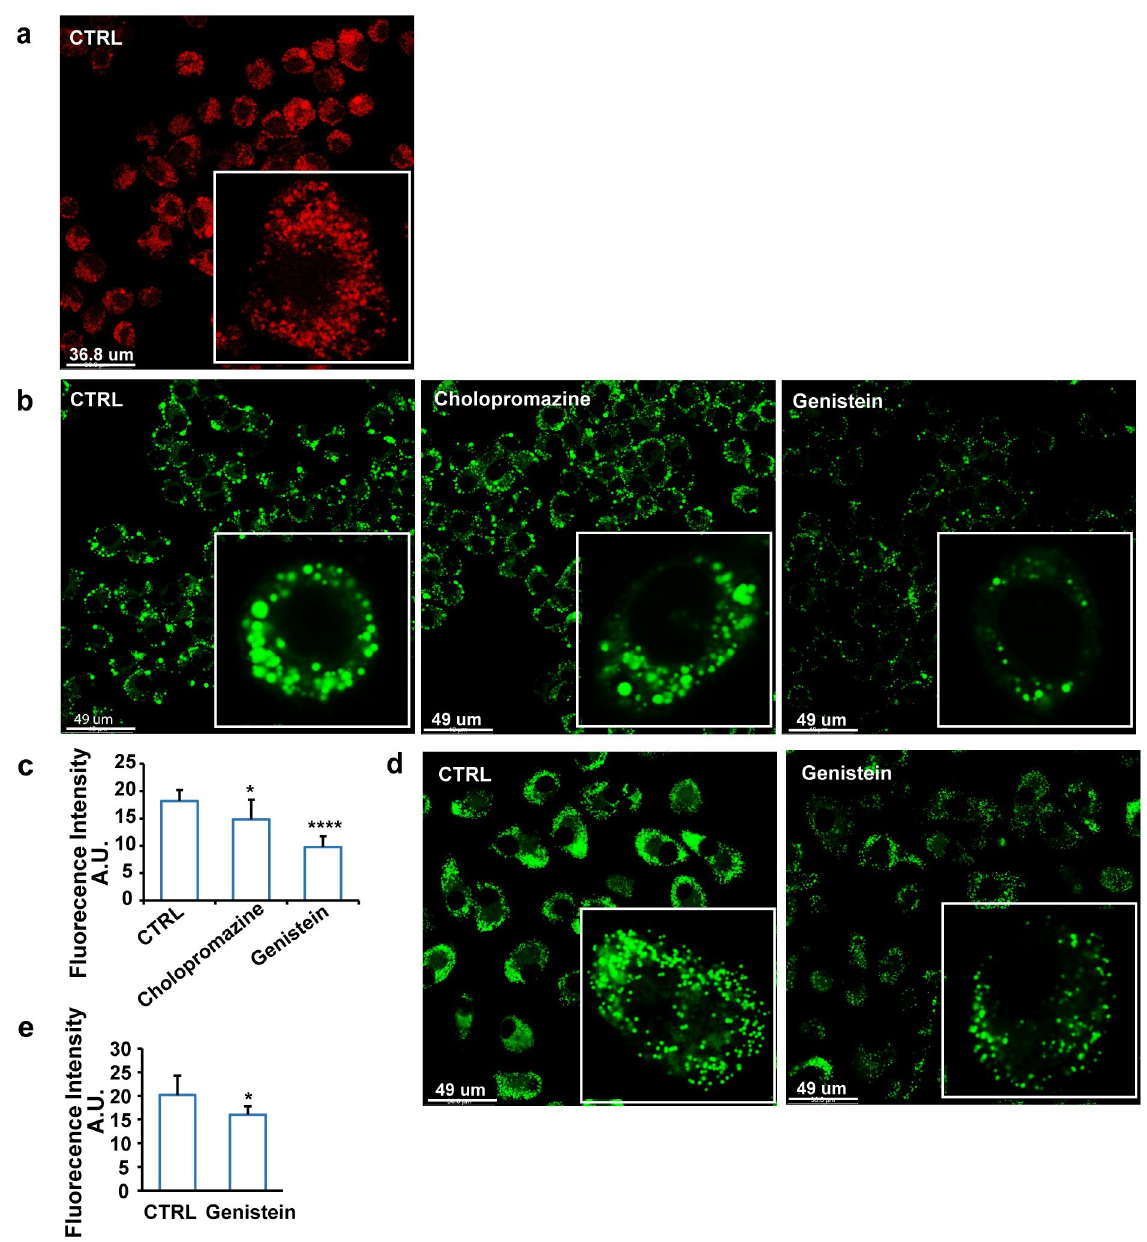
Fig 4. VLDL-sized emulsion particles are taken up by macrophages via caveola-mediated endocytosis. (a) Early endosome staining of RAW 264.7 macrophages treated with 1 mM of VLDL-sized emulsion particles for 6 hours ( n = 6). (b) BODIPY 493/503 staining of RAW 264.7 macrophages treated with 1 mM VLDL-sized emulsion particles for 6 hours in the presence or absence of 10 μ g/ml chlorpromazine or 200 μ M genistein ( n = 6). (c) Mean fluorescence intensity quantified by Image J ( n = 6). (d) BODIPY 493/503 staining of human primary macrophages treated with 0.5 mM VLDL-sized emulsion particles for 6 hours in the presence or absence of 200 μ M genistein ( n = 6). (e) Mean fluorescence intensity quantified by Image J ( n � 3). The bar graphs were plotted as mean ± SD. Asterisk indicates significantly different from control according to Student t test. � p < 0.05, ���� p < 0.0001. (The raw data of bar graphs can be found in “S1 Raw Data”.) VLDL, very low- density